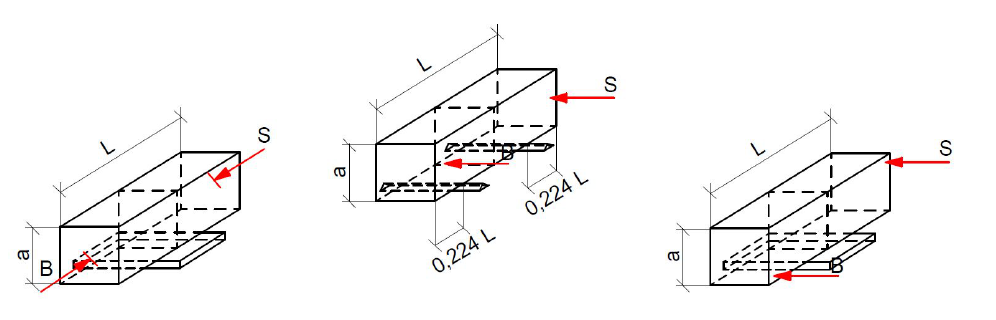
Figure 1. Measurement basic natural frequencies from longitudinal (left), transverse (center), and torsional (right) oscillations.